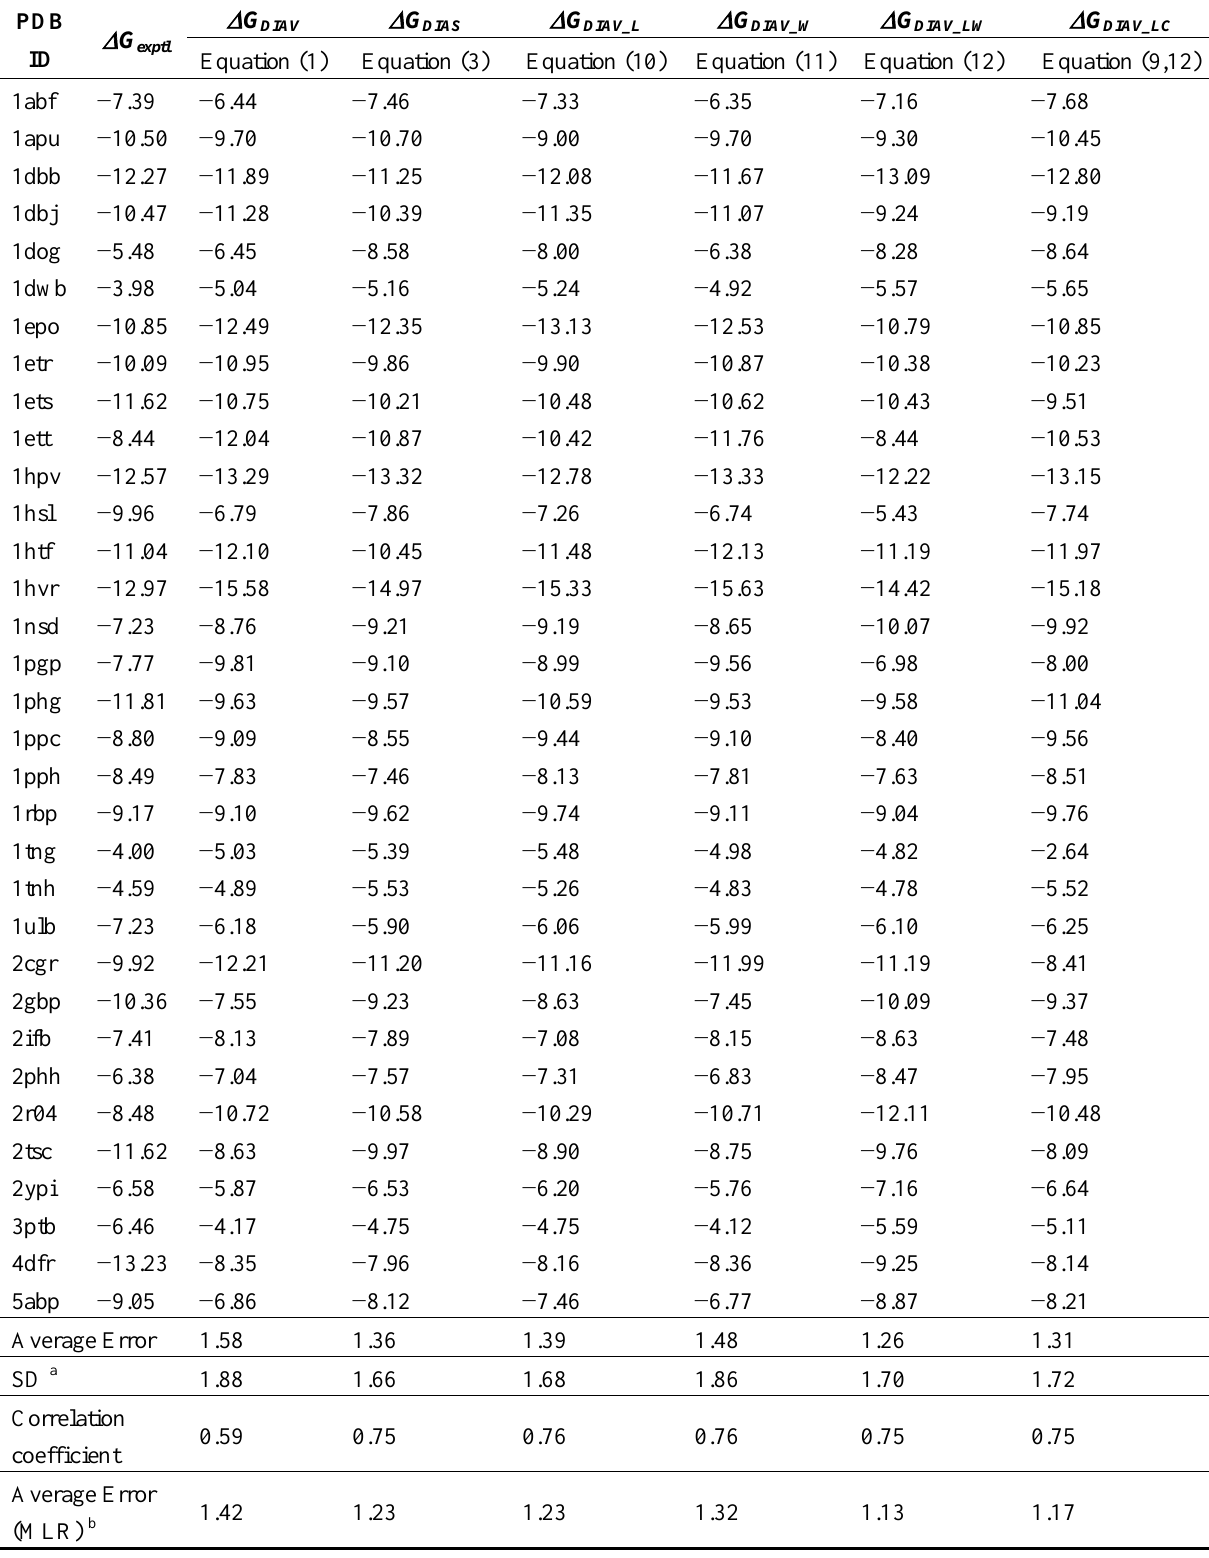
Table 1. Estimated binding free energies by several models and the experimental value (  G